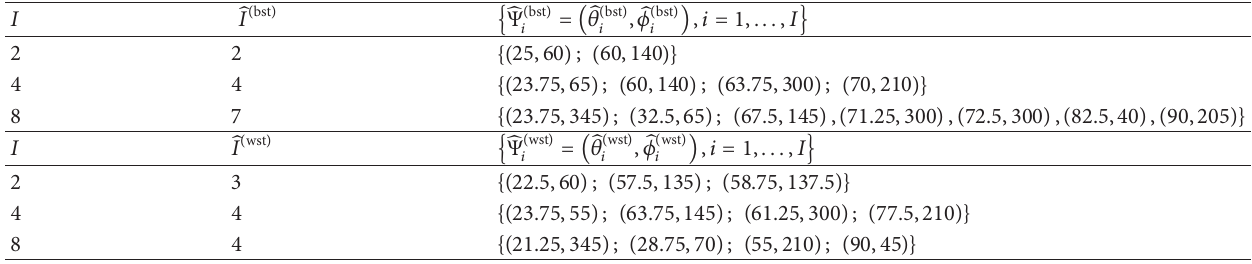
Table 2: Fully populated array—( 𝑁 = 25 ; 𝑑 𝑥 = 𝑑 𝑦 = 0.5𝜆 ; 𝐼 ∈ [2 : 8] ; SNR = 10 dB; 𝑇 = 1 ; 𝐶 = 50 )—values of the DoAs for the best and worst estimation obtained by means of the ST-BCS among the 𝐶 different noisy scenarios.